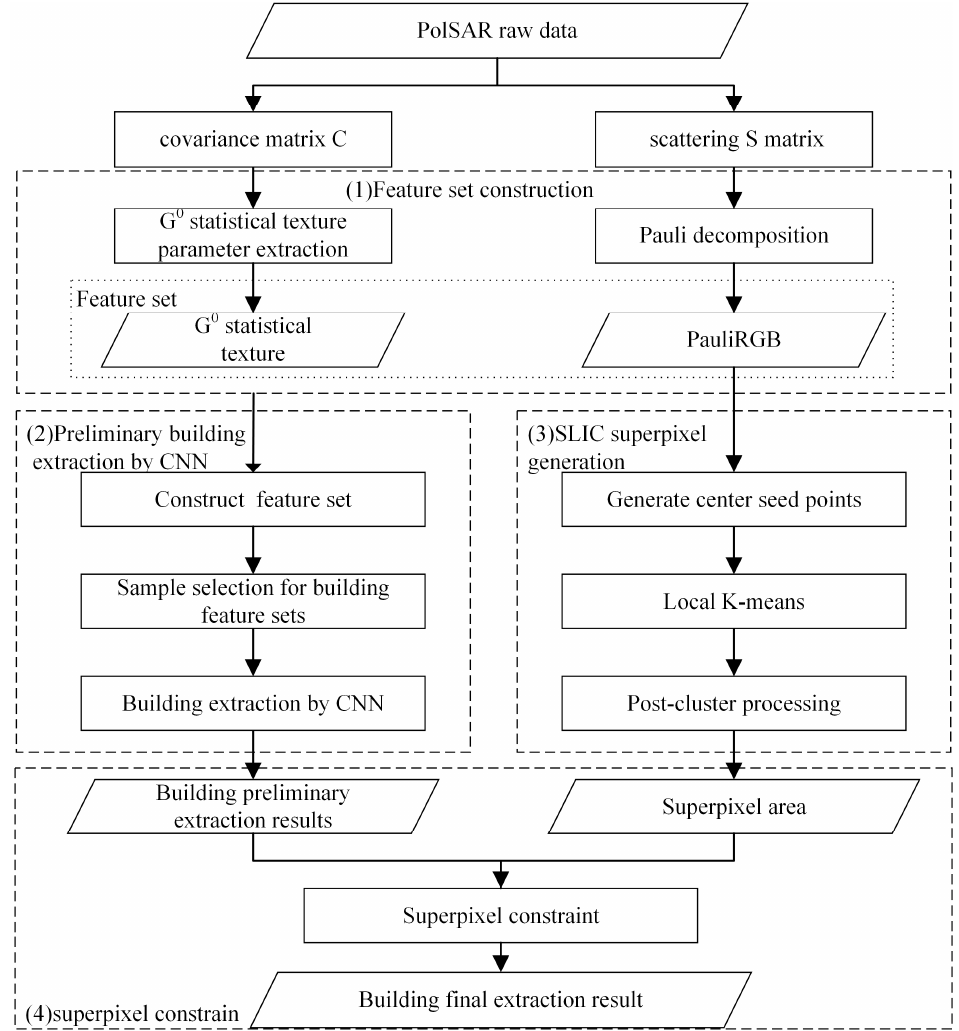
Figure 1. Flow chart of building extraction based on CNN and superpixel in the PolSAR image.